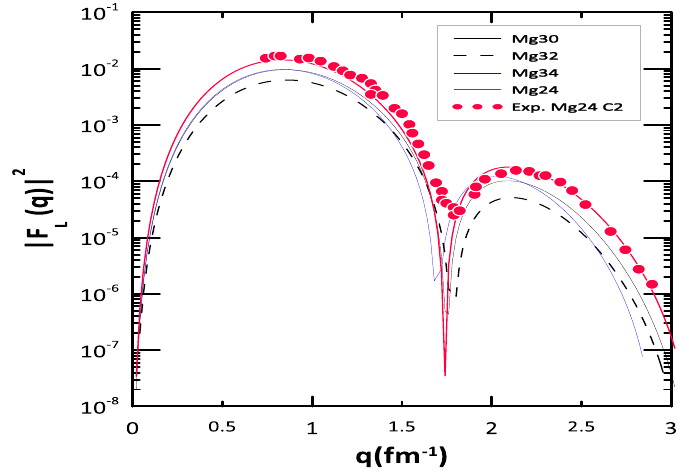
Fig. 9: The relation between moment transfer and form longitudinal factor for 24,30,32,34 Mg